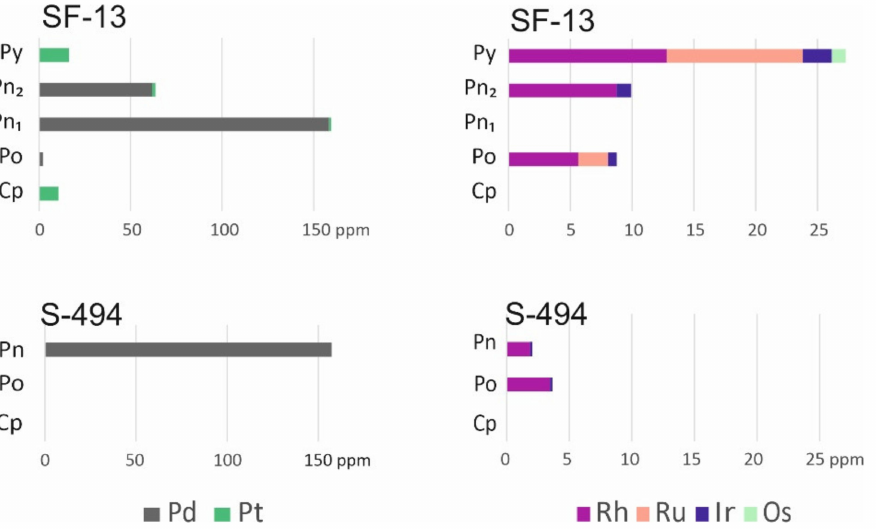
Figure 12. PGE content in BMS for the selected samples: SF-13—pyrrhotite ores (Cu-poor) and S-494—chalcopyrite–pyrrhotite (Cu-bearing), average values in the mineral, presented in Table 6.